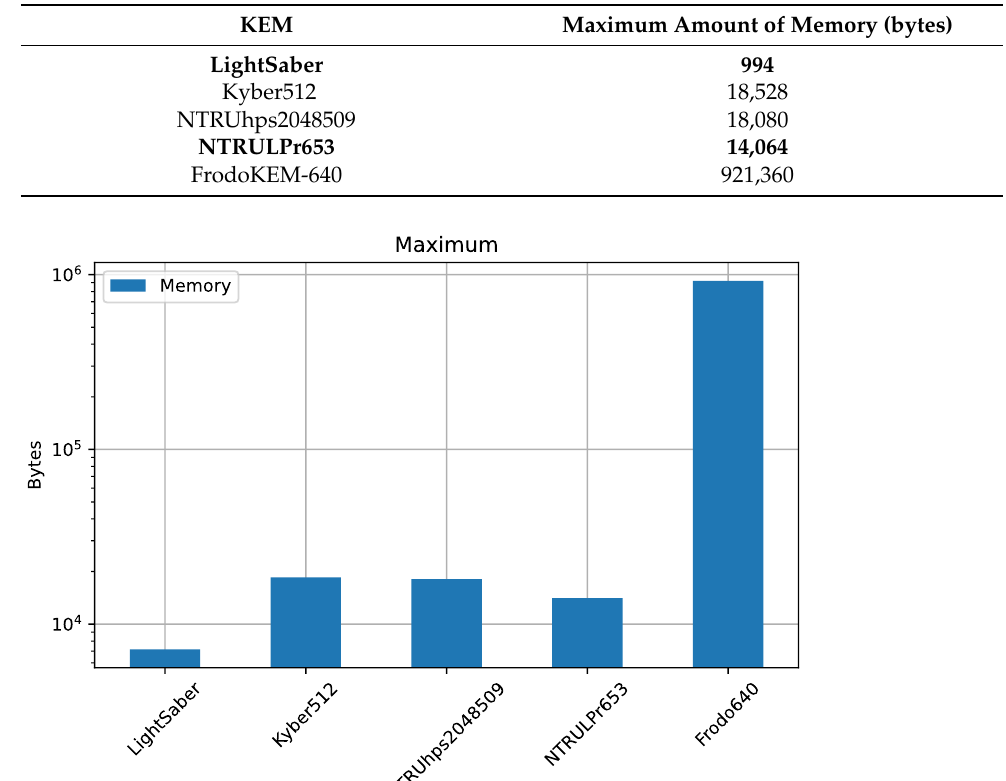
Table 3. The maximum amount of memory each KEM uses. FrodoKEM640 uses the most memory, whilst the KEM that uses the least is LightSaber. The other three use approximately the same amount of memory.